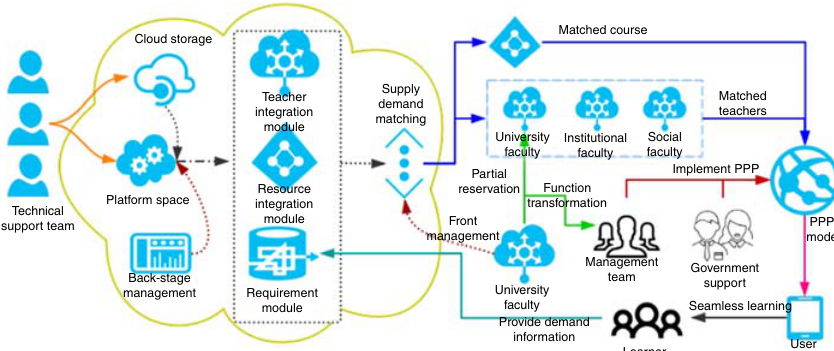
Figure 7. Seamless learning platform system based on PPP